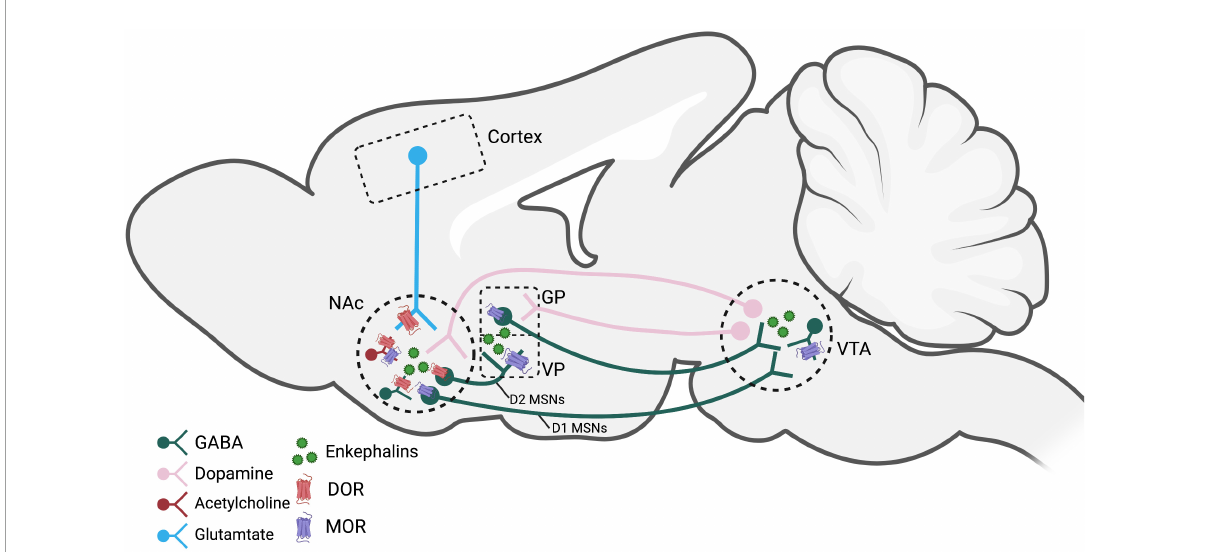
FIGURE1 Brain regions and pathways implicated in enkephalin-mediated reward-related behaviors. Dopamine neurons in the VTA that project to the NAc are modified by MORs on GABAergic interneurons. Activation of MORs and DORs, likely by enkephalins, within the NAc modulate dopamine, GABA, glutamate, and acetylcholine release. D2 MSNs express enkephalin and project to the VP and are believed to be a crucial circuit for reinstatement behaviors. Figure created using Biorender.com. NAc, nucleus accumbens; GP, globus pallidus; VP, ventral pallidum; VTA, ventral tegmental area; MOR, mu opioid receptor; DOR, delta opioid receptor; MSNs, medium spiny